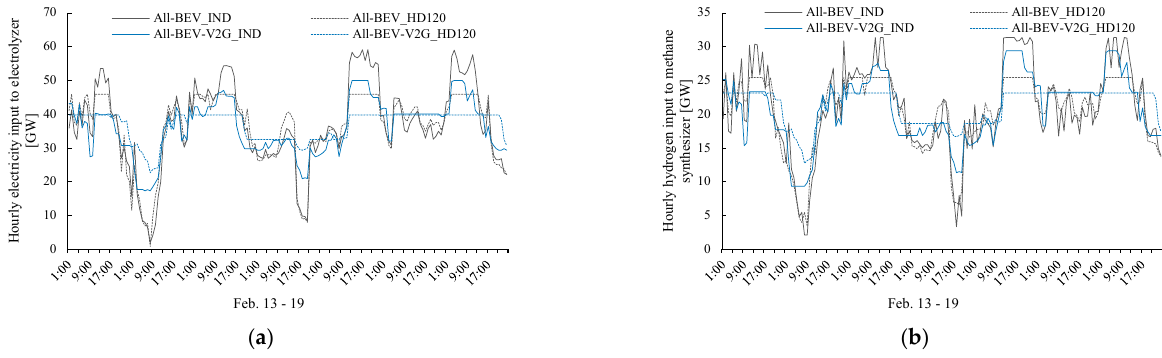
Figure 7. Hourly operation of Power-to-Gas technology in each scenario ( a ) Electrolyzer. ( b ) Methane synthesis.